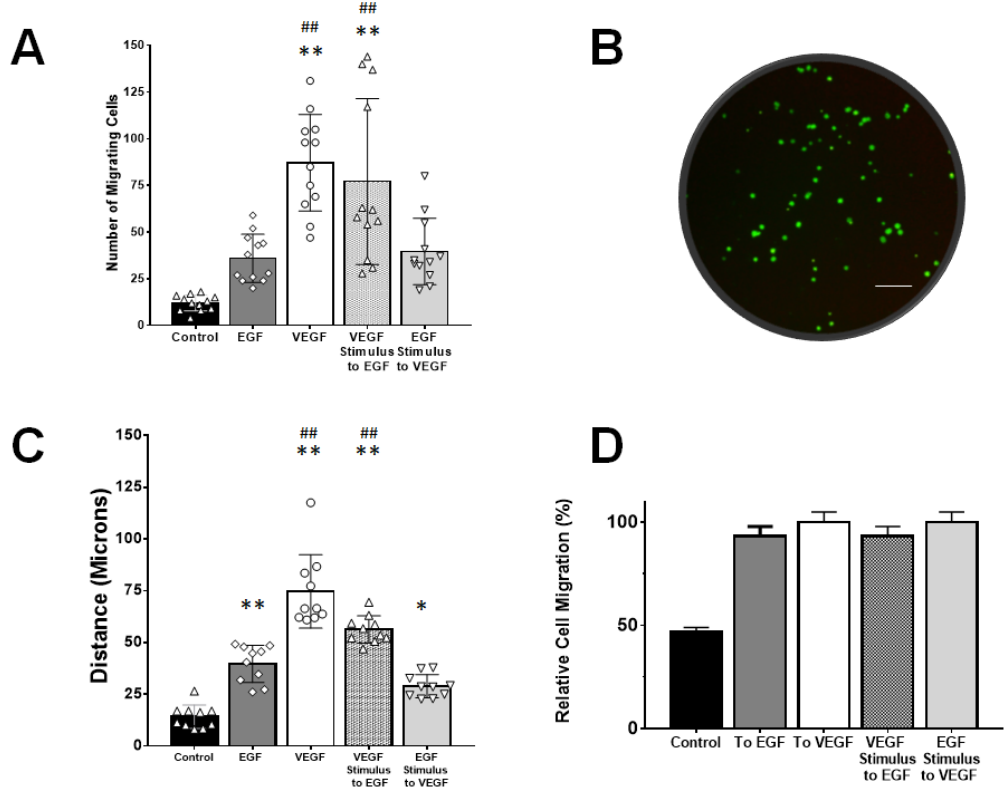
Figure 4. Müller glia migration in response to exogenous signaling produced within transwell assays (TA) and the gLL microfluidic system. ( A ) Fold-change in numbers of rMC-1 that migrated towards concentration gradient profiles of VEGF and EGF established with TA. Numbers of motile rMC-1 were also measured in response to control (no gradients, media only) and a mixed signaling condition of rMC-1 pre-treated with VEGF responding to EGF signaling fields. ( B ) Bottom of TA membrane displaying fluorescently labeled cells that migrated through it. Scale bar is 200 µ m. ( C ) Average path lengths, or accumulated distances, of rMC-1 that became motile in response to signaling fields of EGF and VEGF created within the gLL microfluidic system. Conditions of mixed VEGF / EGF signaling and control were also produced as with the TA platform. ( D ) Average fraction of motile cells in response to signaling fields within the gLL system. Statistical significance denoted by * ( p < 0.05) and ** ( p < 0.01) with respect to control; ## represents statistical di ff erence ( p < 0.01) among the groups with respect to the EGF group.